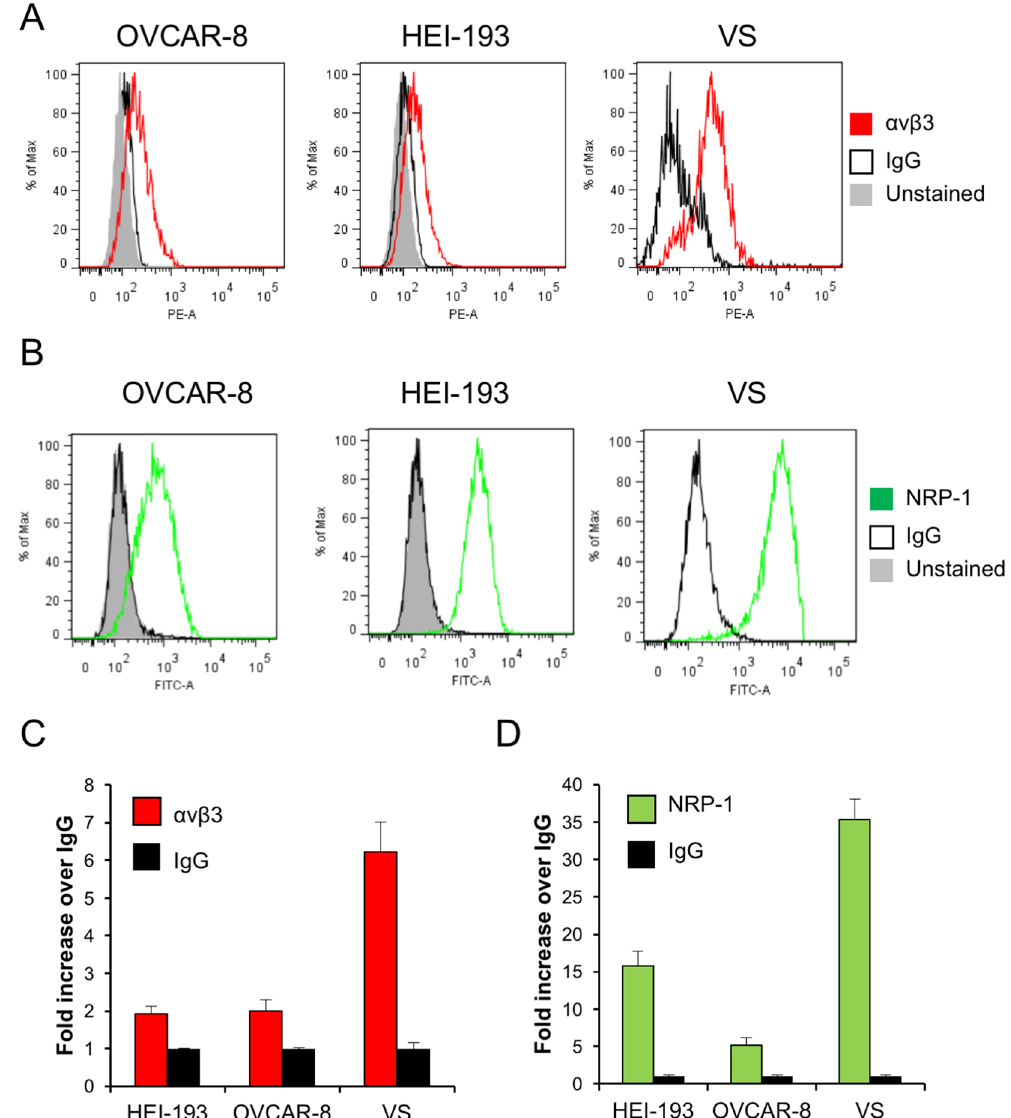
Figure 3. Expression of α v integrins and NRP-1 in cell lines and primary VS cultures as determined by flow cytometry. ( A ) Flow cytometry analysis of α v β 3 integrin expression in OVCAR-8 (left panel), HEI-193 (center panel), and human VS cultures (right panel). Red, α v β 3 integrin antibody. Black, IgG isotype control. Shaded histogram represents unstained OVCAR-8 or HEI-193 cells. Representative histograms from six independent replicates are shown. ( B ) Flow cytometry analysis of NRP-1 surface expression. Red, NRP-1 antibody. Black, IgG isotype control. Shaded represents unstained OVCAR-8 or HEI-193 cells. Representative histograms from six independent replicates are shown. ( C ) Quantification of α v β 3 integrin expression in cell lines and human VS cultures. Red bars, anti- α v β 3 antibody; black bars, IgG control antibody. Error bars represent standard deviation. (n = 6 independent replicates for cell lines, 4 different tumors for VS cultures). ( D ) Quantification of NRP-1 expression. Green bars, anti-NRP-1 antibody; black bars, IgG control antibody. Error bars represent standard deviation. (n = 6 independent replicates for cell lines, 4 different tumors for VS